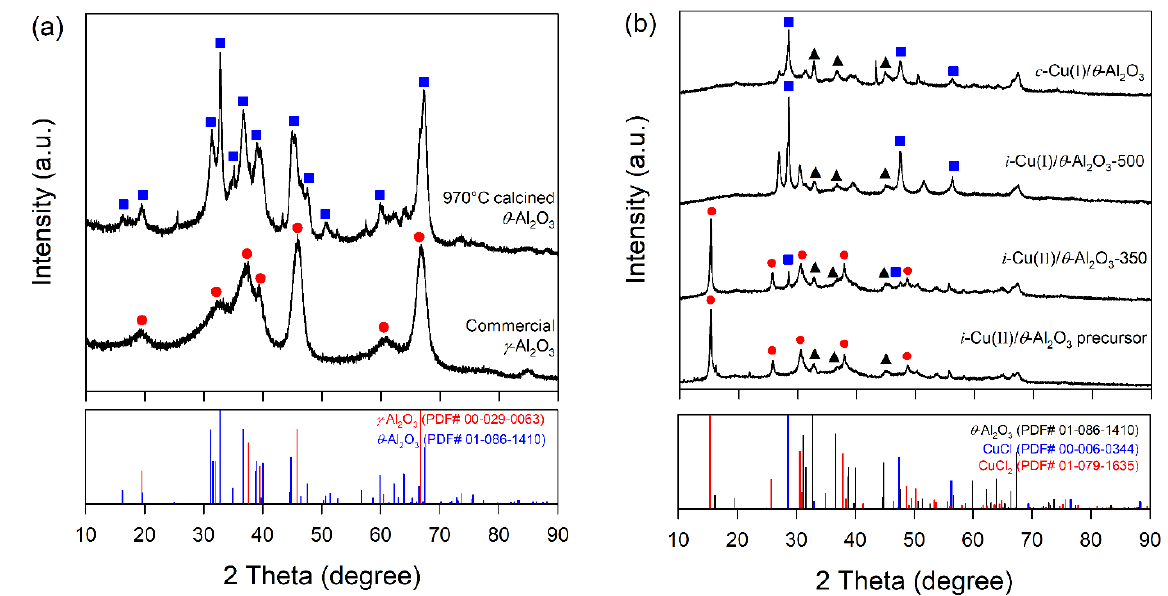
Figure 2. ( a ) Untreated γ-Al 2 O 3 and θ-Al 2 O 3 calcined at 970 °C; ( b ) XRD patterns of i-Cu(II)/θ-Al 2 O 3 precursor, i-Cu(II)/θ-Al 2 O 3 -350, i-Cu(I)/θ-Al 2 O 3 -500, and c-Cu(I)/θ-Al 2 O 3